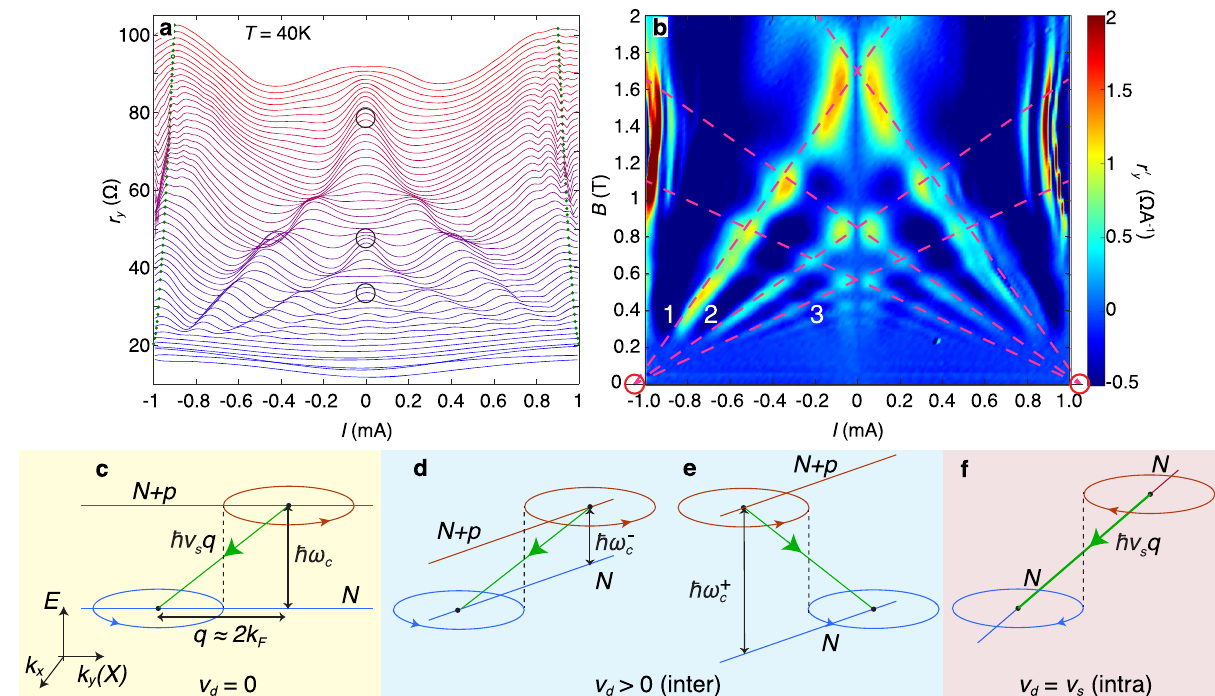
Fig. 2 Non-equilibrium magnetoresistance oscillations at T = 40 K: magnetophonon resonance splitting and the Mach effect. a Plot of differential resistance r y ( I ) for B between 0 and 2 T in 0.04 T intervals and b the corresponding colour map of r 0 y ð I ; B Þ ¼ (cid:2) sgn ð I Þ d r y = d I , measured at T = 40 K and n = 3.16 × 10 12 cm − 2 . In a , the curves are offset by 1.5 Ω and the open circles indicate the magnetophonon resonance peaks p = 1, 2, 3 under ohmic conditions when I = 0. The green markers show the position of the peak in the resonance at v d ≈ v s given by Supplementary Eq. (1). In b , the dashed magenta lines are a fi t given by Eq. (7) when v s = v TA and p = 1, 2, 3 (labelled). The red circles at the left and right hand corners of the colour map highlight the point of convergence of the magenta lines when B = 0. c – f show energy – momentum diagrams in applied B and F x to demonstrate the semiclassical conditions for strong scattering between initial (red, N + p ) and fi nal (blue, N ) Landau states when: c , v d ≈ 0, corresponding to ohmic MPR; d , e v d < v s , corresponding to Hall fi eld-induced splitting of the MPR features when B ¼ B (cid:2) p ( d ) and B ¼ B þ p ( e ). f v d = v s , corresponds to intra-LL acoustic phonon scattering. In c – f , the red and blue circles show the semiclassical trajectories of the carriers in k- space, and the red and blue lines show the energies of the initial and fi nal Landau states and their dependence on k y ( X ) in the fi nite Hall fi eld. The dashed vertical line shows the points of intersection of the semiclassical fi gure-of-8 orbits when q = 2 k F . The arrowed green lines show the phonon-assisted transitions between LLs, c – e , and within a single LL, f